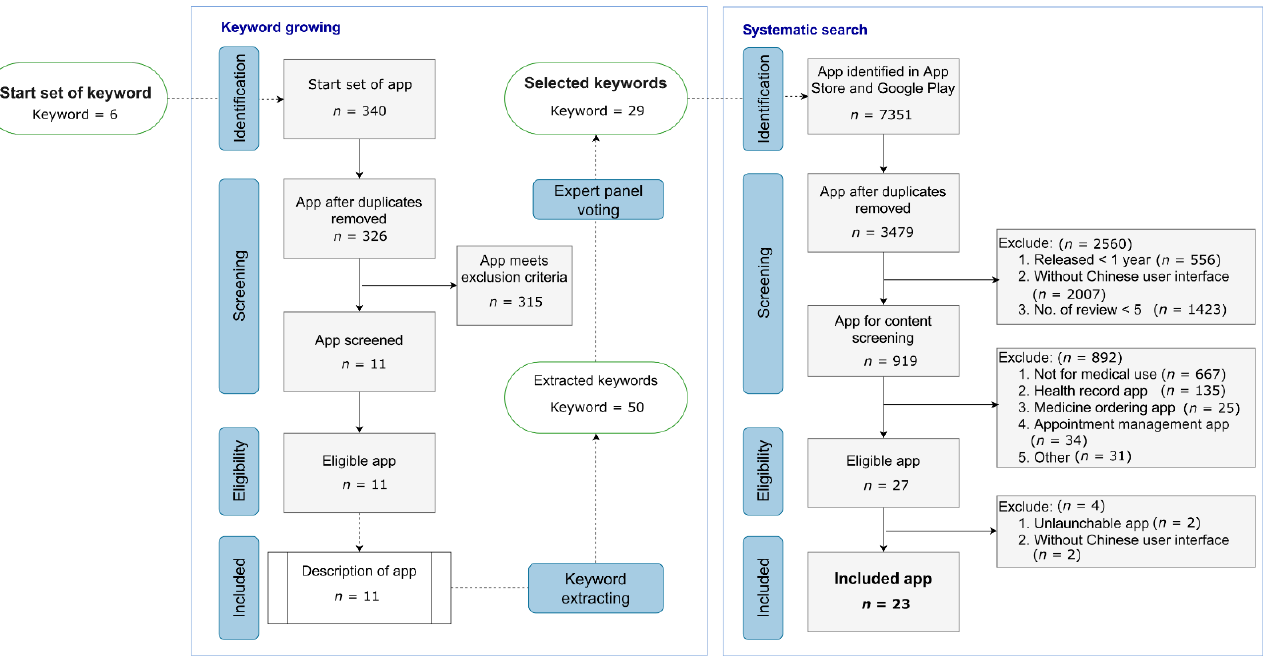
Figure 1. Flow diagram of KESS (Keyword growing and Systematic Search) algorithm and drug reference apps included in this study. ( n = 23, Taiwan, 2021).